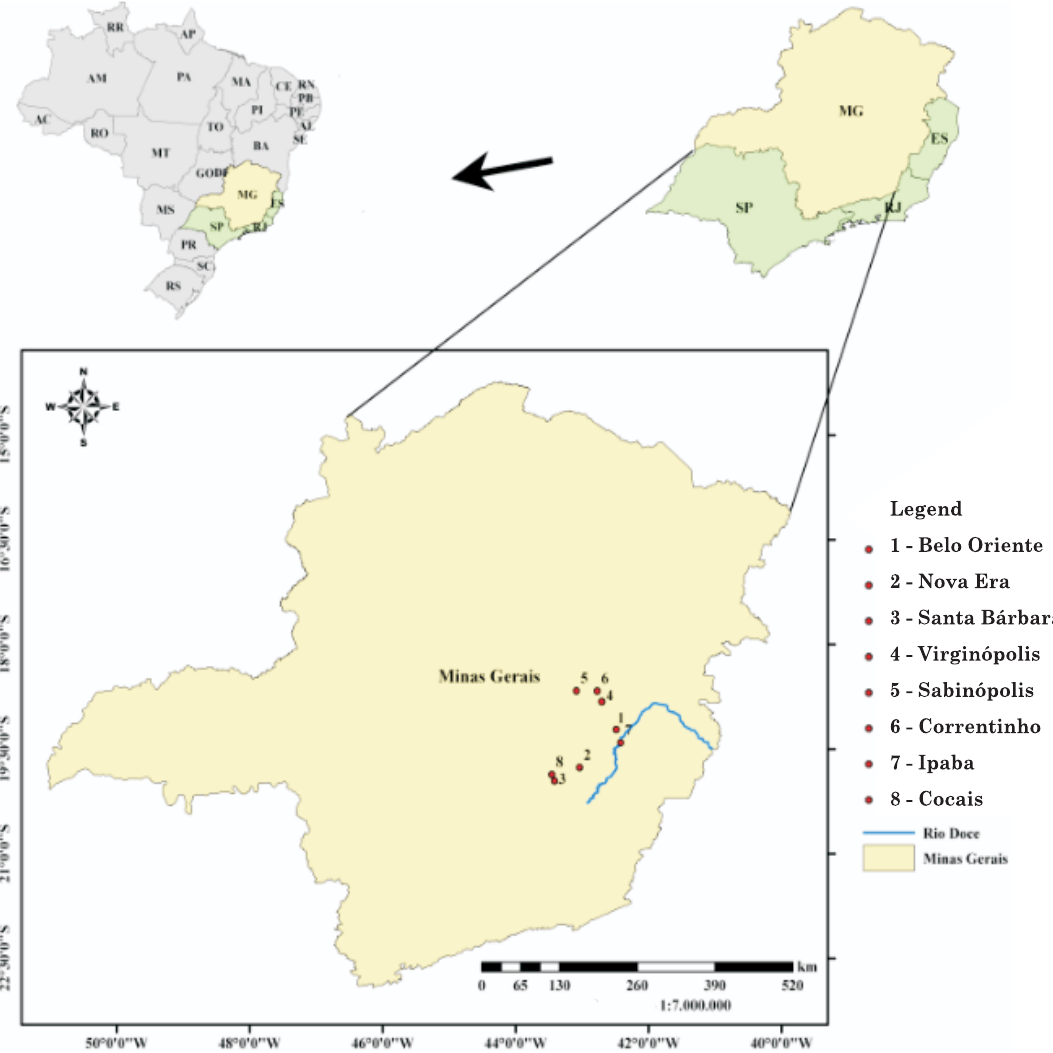
Figure 1. Geographic localization of the eight regions studied in the Rio Doce Valley, Minas Gerais,